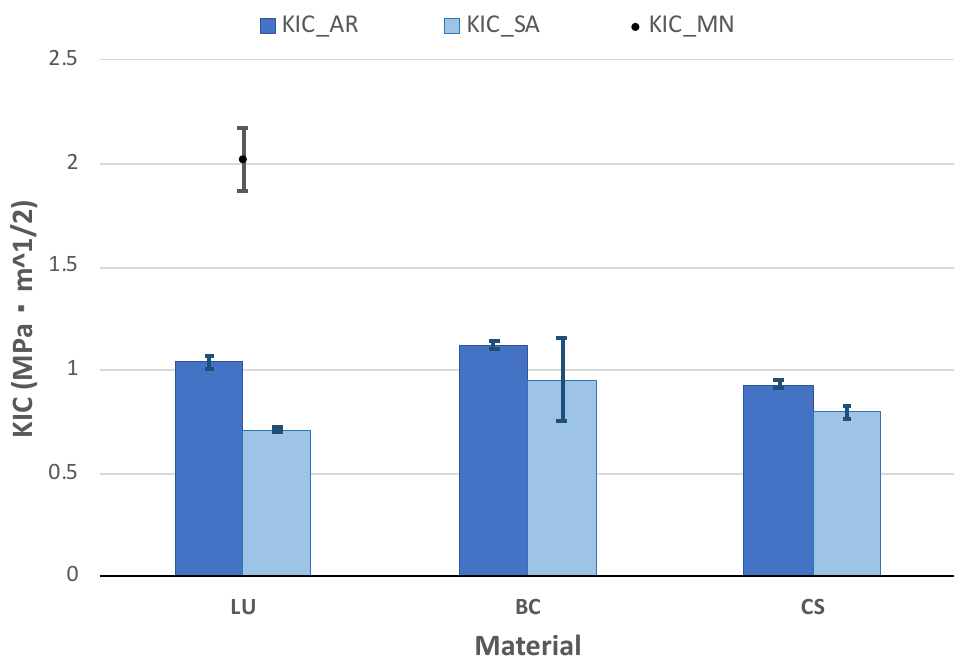
00.511.522.5 Figure 9. Mean fracture toughness and standard error after the TPB tests in the SELNB samples of the materials AR and after immersion in AS. Dentin fracture toughness is marked with the shaded area. Figure 10. Fracture surfaces of the ( a ) LU, ( b ) BC ( b ), and ( c ) CS materials after a TPB test.